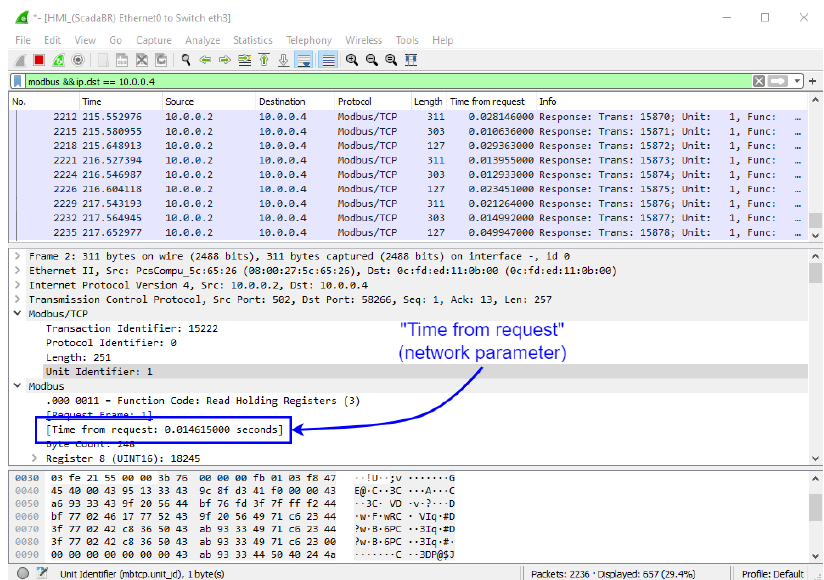
Figure 28. Time from request—Wireshark snapshot.